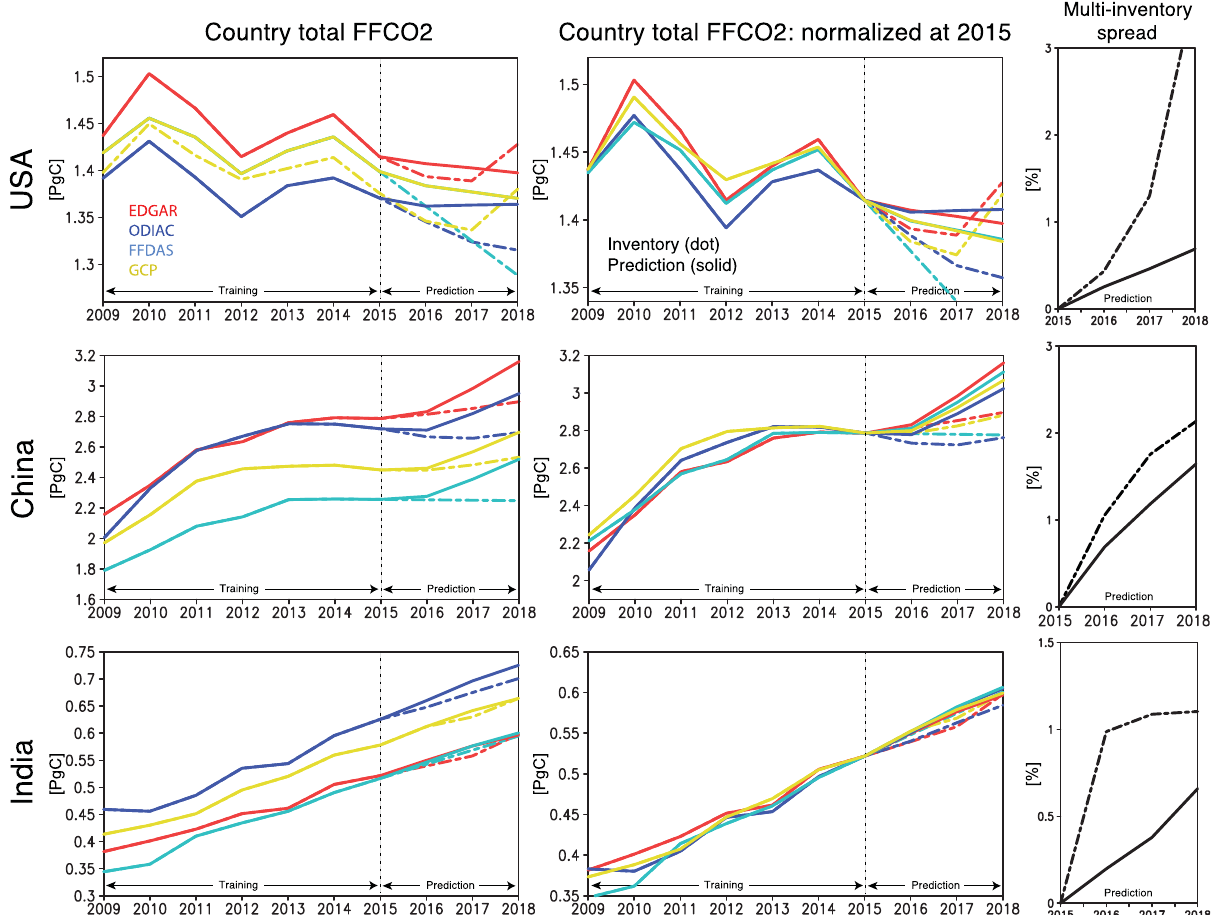
Fig. 5 | Temporal evolution of fossil fuel CO 2 (FFCO 2 ). (Left) Time series of country total fossil fuel CO 2 (FFCO 2 ) obtained from multiple inventories: EDGAR (red), ODIAC (blue), FFDAS (magenta), and GCP (orange) during 2009 and 2018. The original inventory values are shown by dotted lines. The Kalman fi lter (KF) prediction results, with training before 2015, are shown by solid lines. (Center) Similar to the left panels, but the emissions inventories shifted to a common value